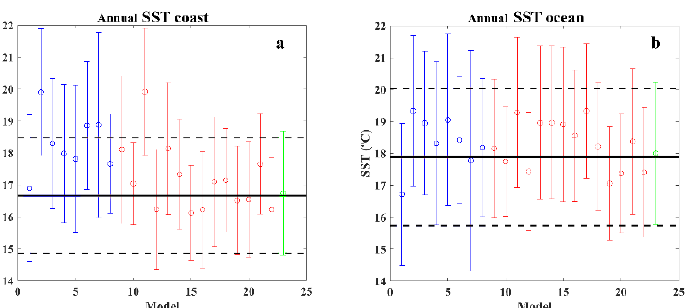
Figure 7. Humboldt upwelling system mean SST value (±1 SD) for the OISST ¼ (black solid line) and each CMIP6 model for: ( a ) coastal and ( b ) oceanic points. The number and color of each model refer to Table 1.